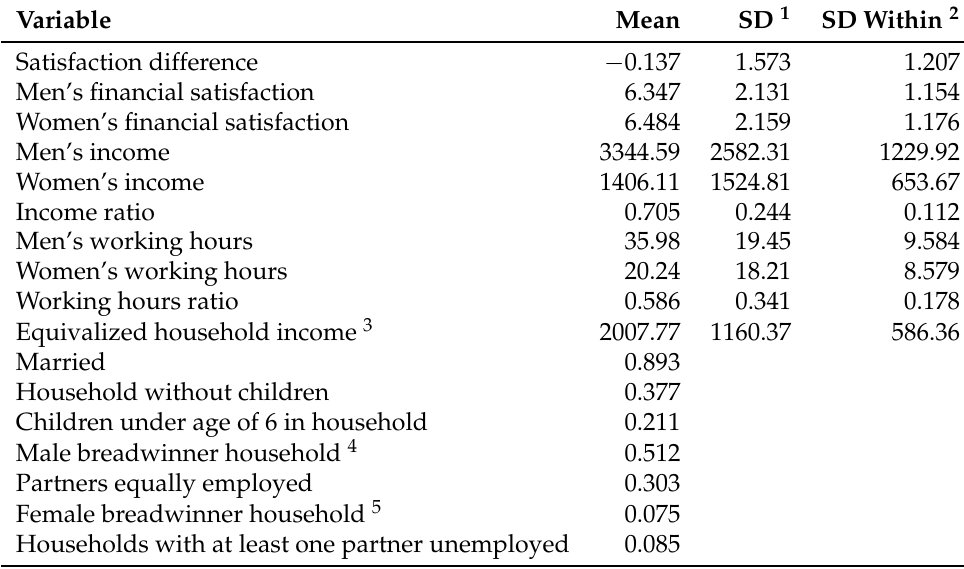
Table 1. Sample mean and standard deviation of relevant